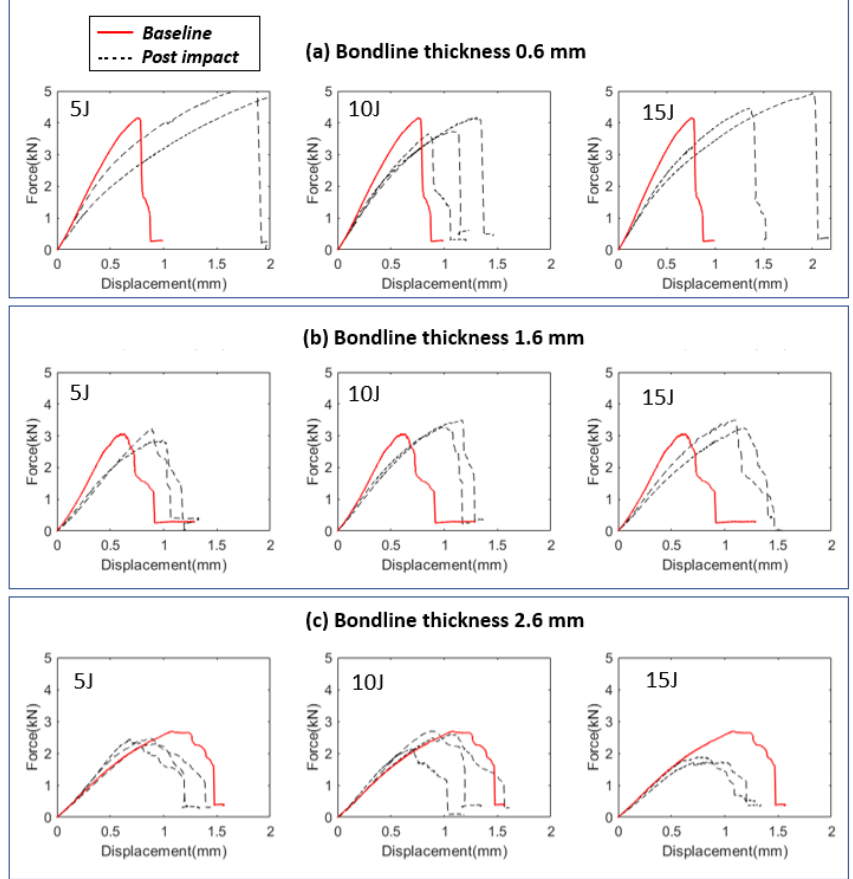
Figure 24. Comparison of post-impact load displacement history with intact load displacement history (baseline) for different bondline thicknesses and impact